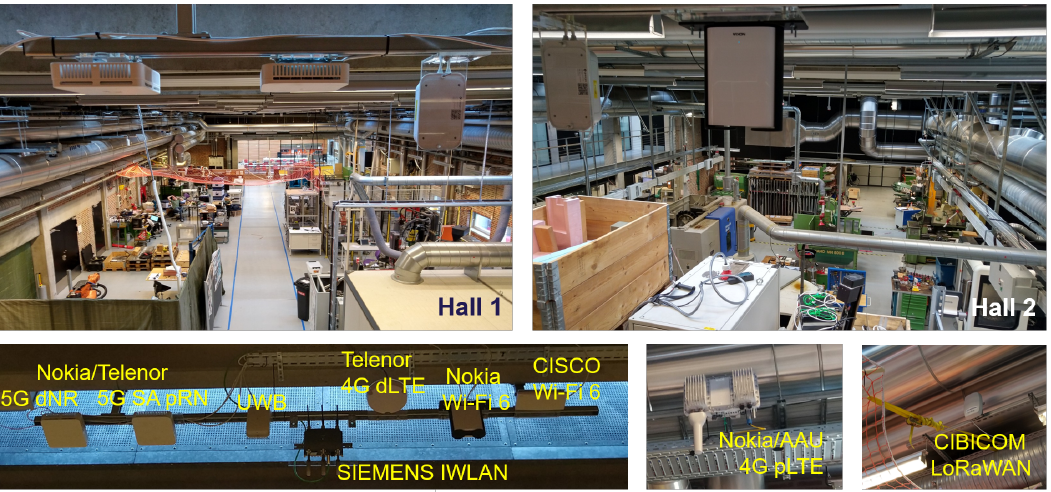
Figure 2. Overview of the Aalborg University 5G Smart Production Lab, including details on the two industrial halls and the different operational wireless network